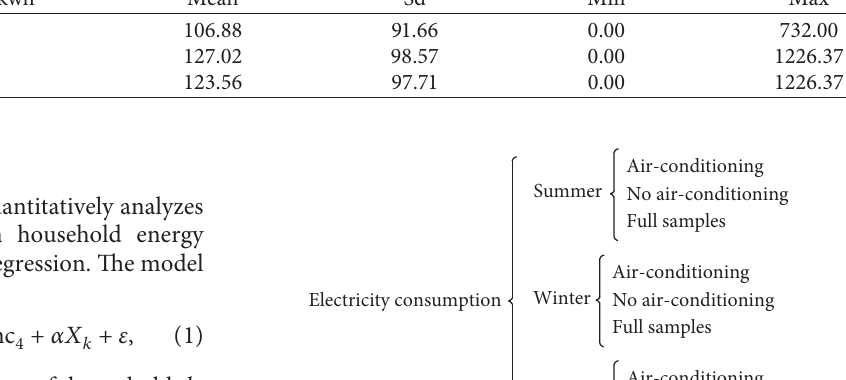
Table 2: Basic descriptive statistics of monthly average electricity consumption of families with and without air-conditioning. Average monthly electricity consumption/kwh